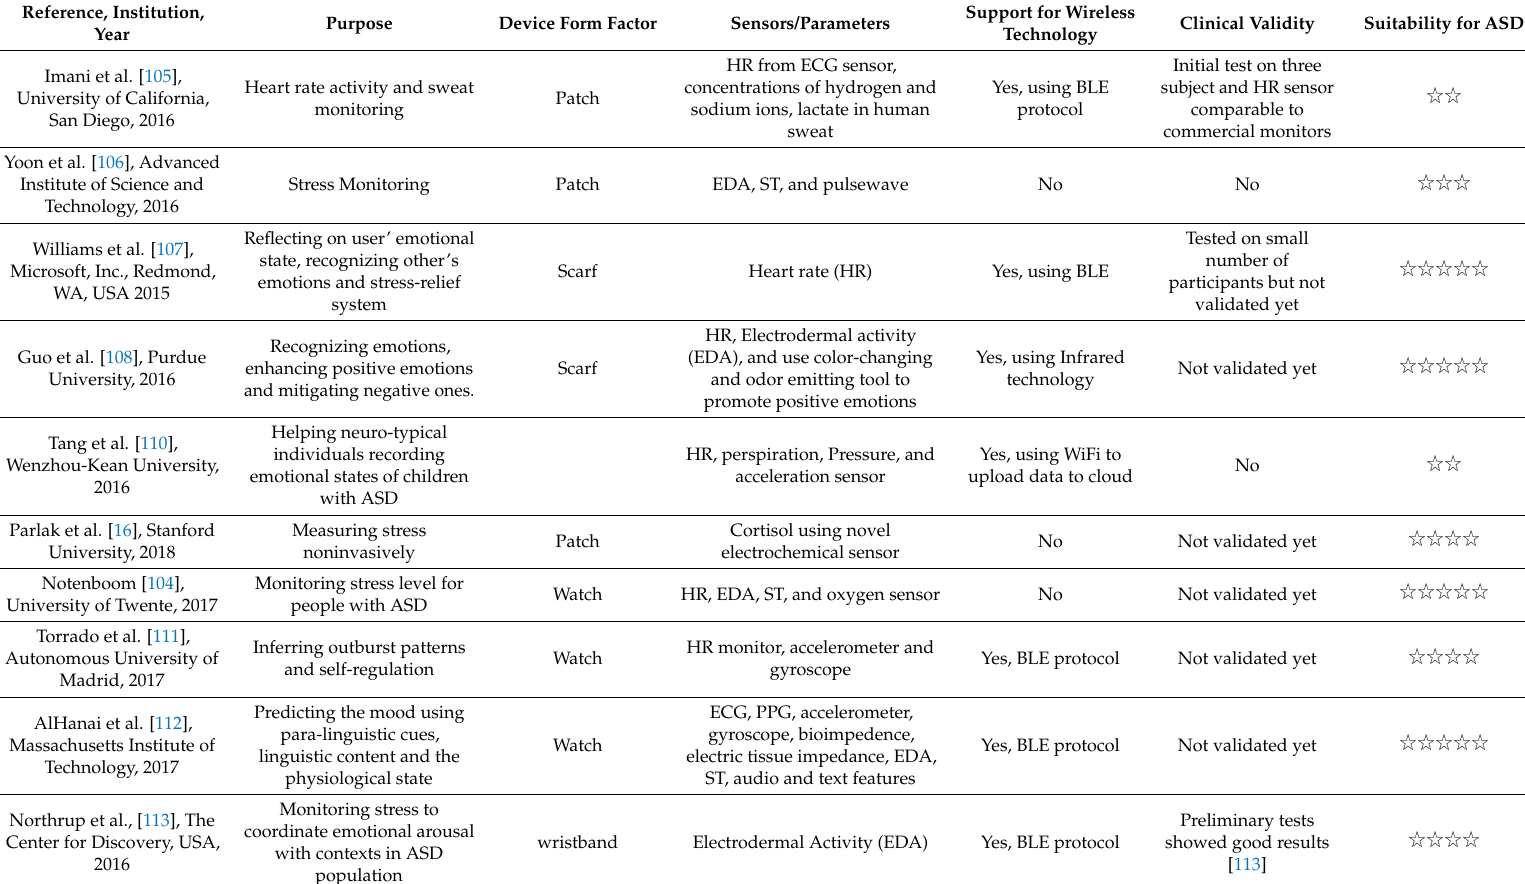
Table 2. Comparison of physiological and emotional recognition/monitoring research